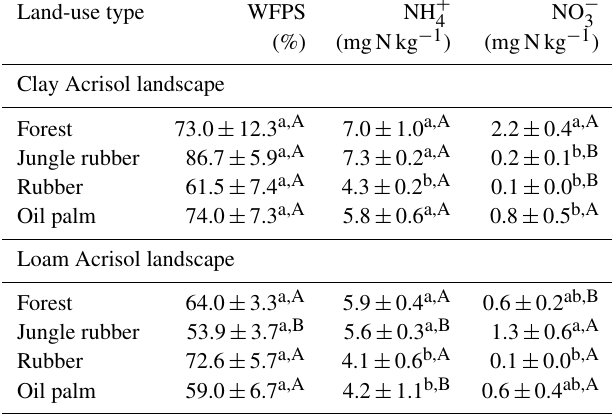
Table A3. Mean ( ± SE, n = 4 sites) soil water-filled pore space (WFPS) and extractable mineral N in the top 0.05m depth for different land uses within each landscape in Jambi, Sumatra, Indonesia. Means followed by different lowercase letters indicate significant differences among land uses within each landscape and different capital letters indicate significant differences between landscapes within each land use (linear mixed-effect models with Fisher’s LSD test at P ≤ 0 . 05). These soil factors were reported by Hassler et al.